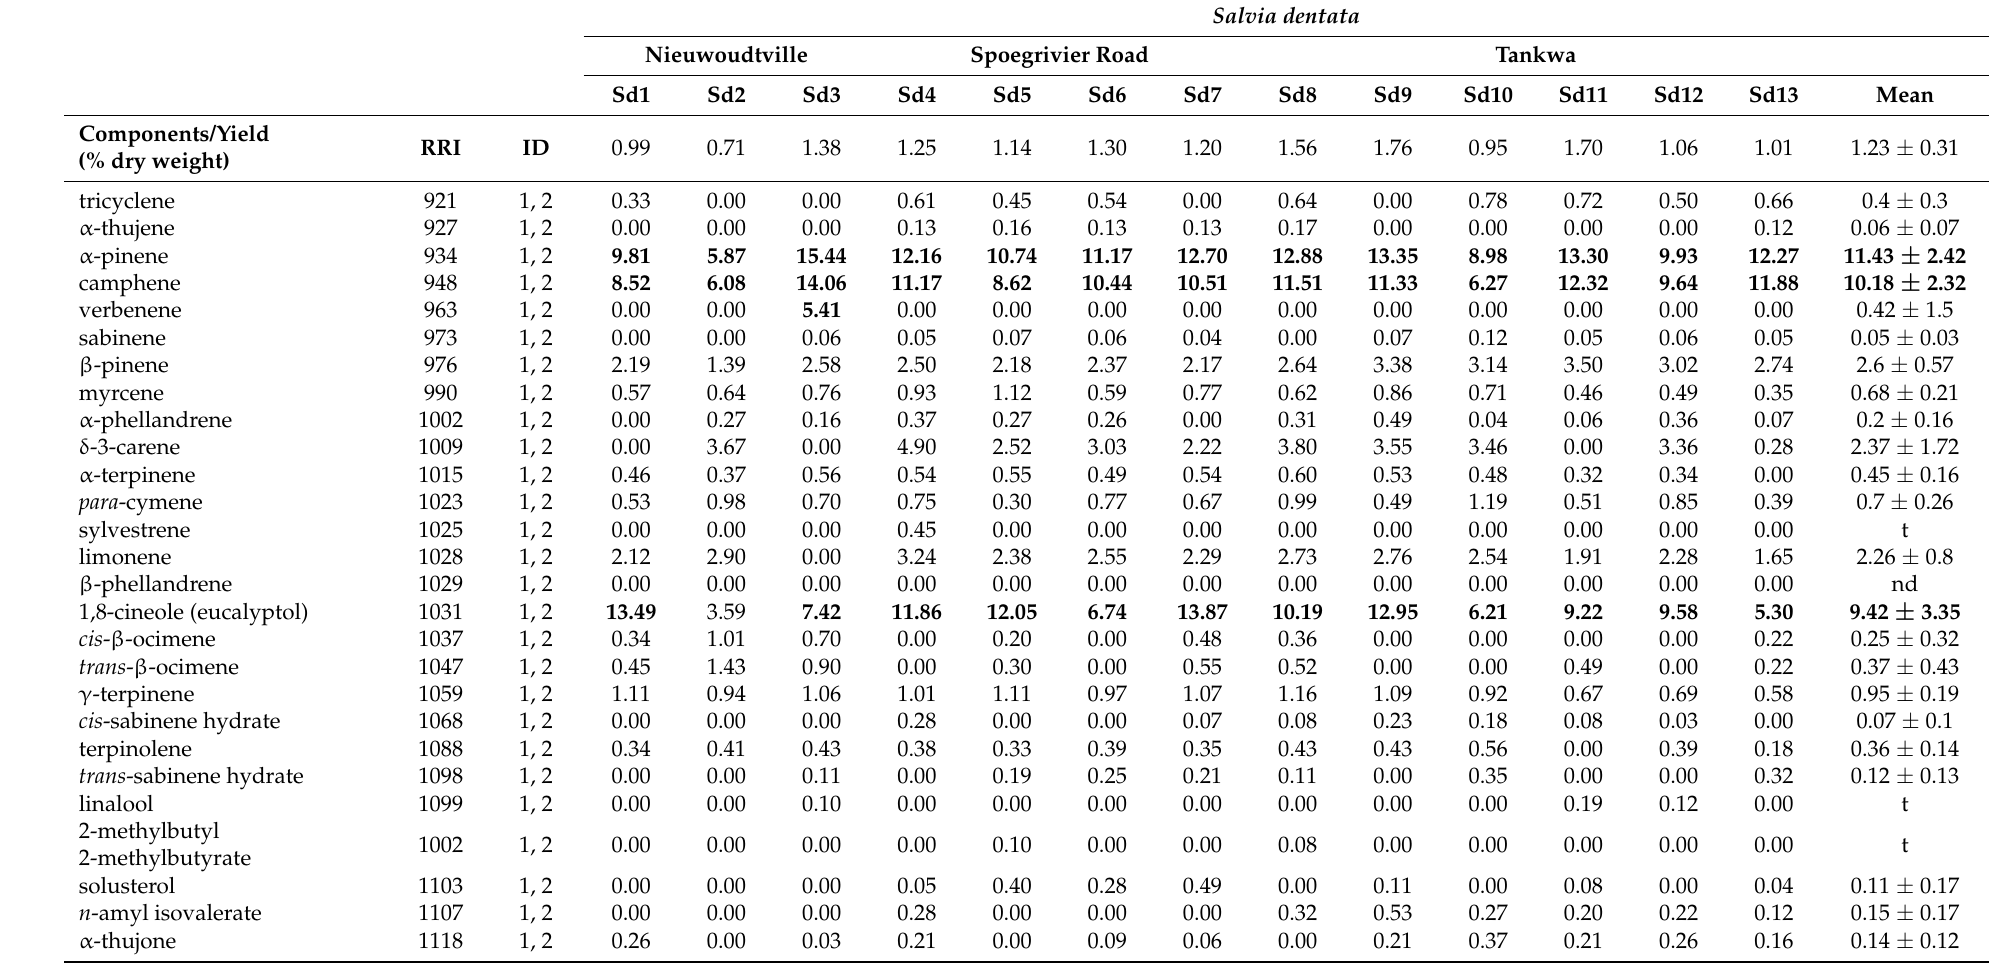
Table 2. Identified essential oil components (%) of Salvia dentata